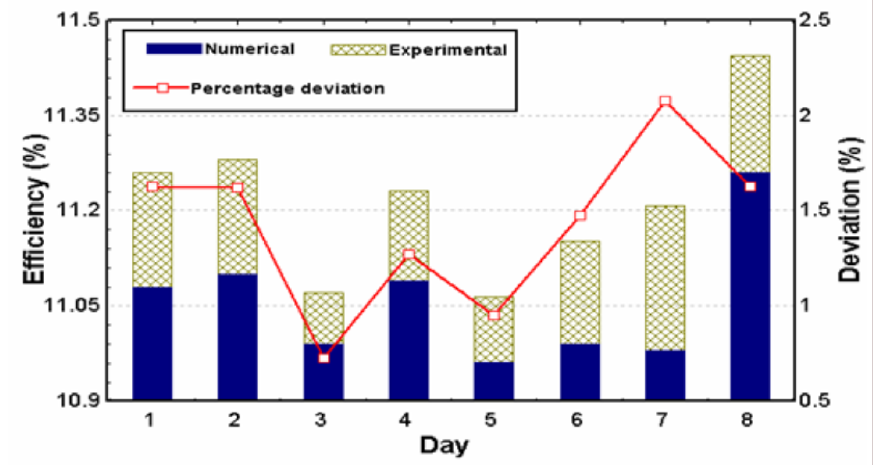
Figure 6. Model validation